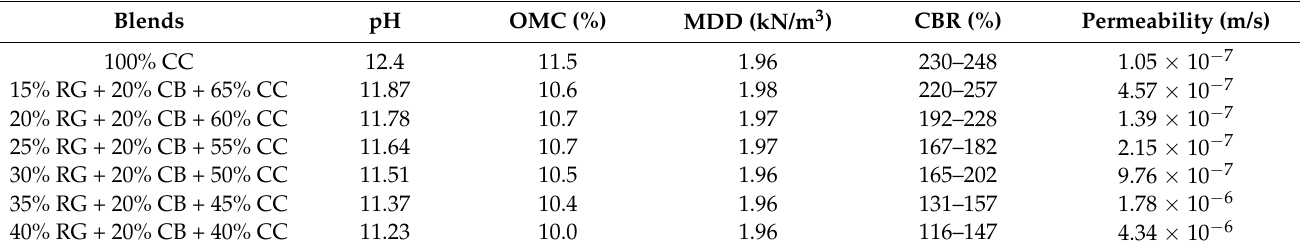
Table 2. Engineering properties of the nominated